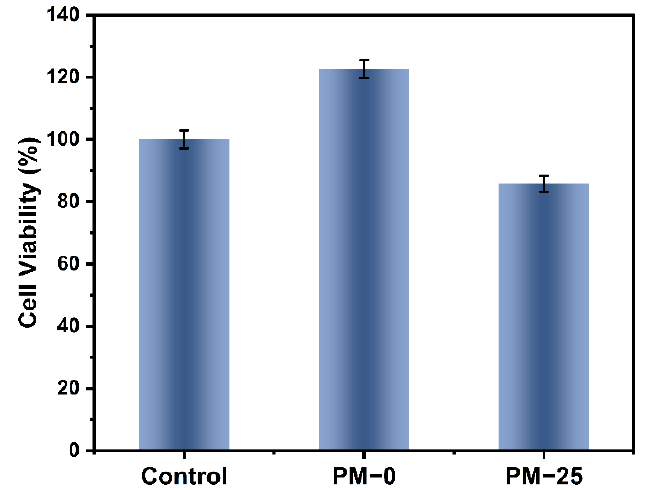
Figure 8. Cell viability of L929 fibroblasts on membranes of PM − 0 and PM − 25 NFMs ( n = 3).